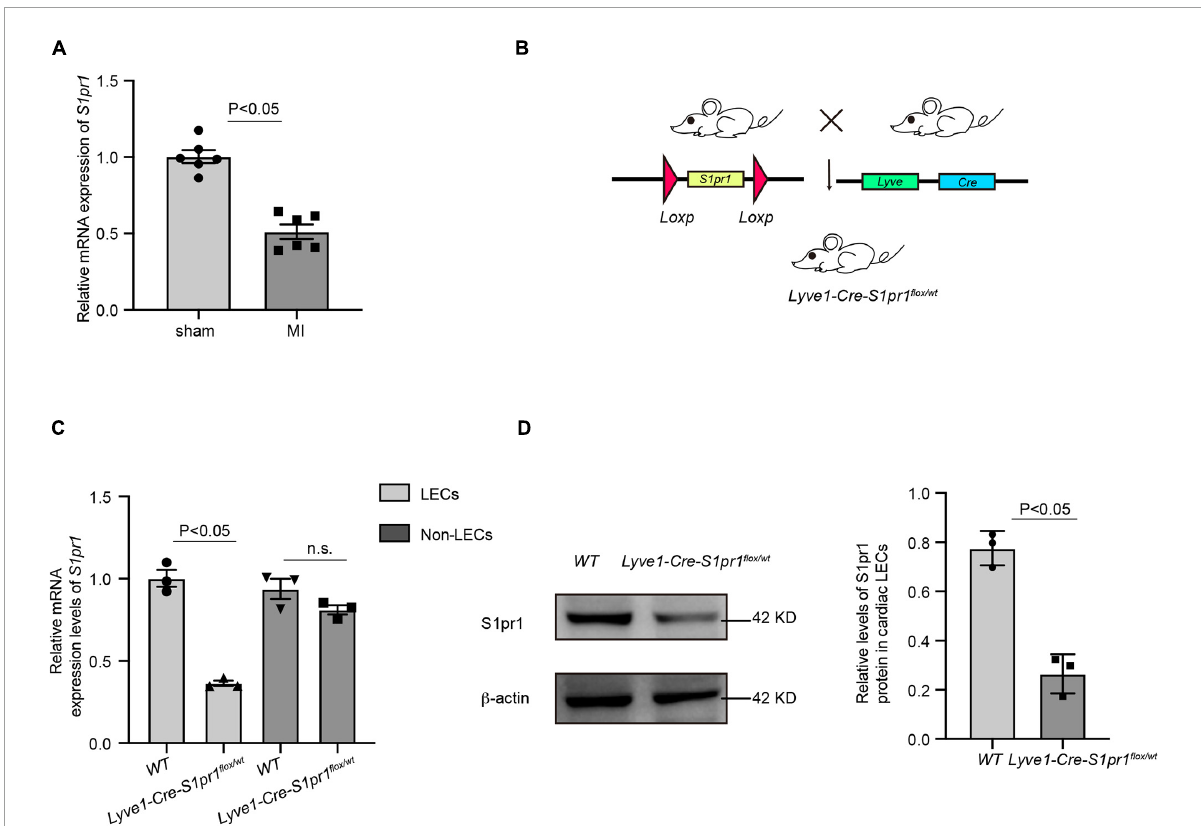
FIGURE1 The expression of S1pr1 was down-regulated in cardiac lymphatic endothelial cells. (A) Relative mRNA expression levels of S1pr1 in cardiac LECs of mice at 3 days after sham or LAD operation ( n = 6). (B) Schematic diagram of generation of mice with LEC-specific loss of S1pr1 allele. (C) Relative mRNA expression levels of S1pr1 in cardiac LECs of WT and Lyve1-Cre-S1pr1 flox / wt mice ( n = 3). (D) Western-blotting analysis of S1pr1 expression in cardiac LECs from the indicated groups, with its quantification ( n = 3). Data are mean ±